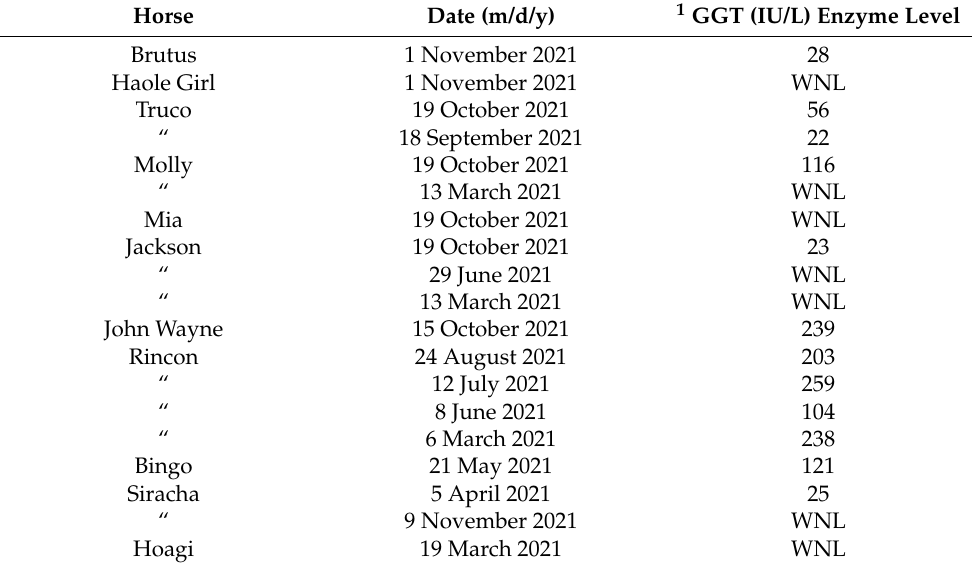
Table 2. Veterinary serum chemistry reports and chronology of GGT levels of Hawaii Polo Club’s 20 horses after isolation to clean paddocks. Hawaii Polo Club and Hawaii Polo Trail Rides blood test data 2020–2021 (* Indicates horse dead). Source: unpublished diagnostic report, Dr. Manuel G. Himenes, ABVP Oahu Equine Veterinary